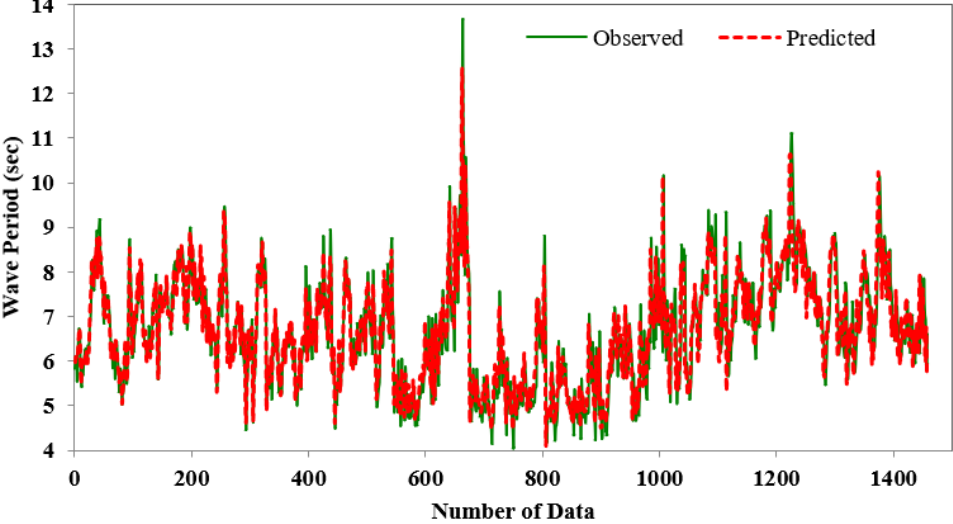
Figure 3. Comparison of ANN results and observed data of wave period for the training results.